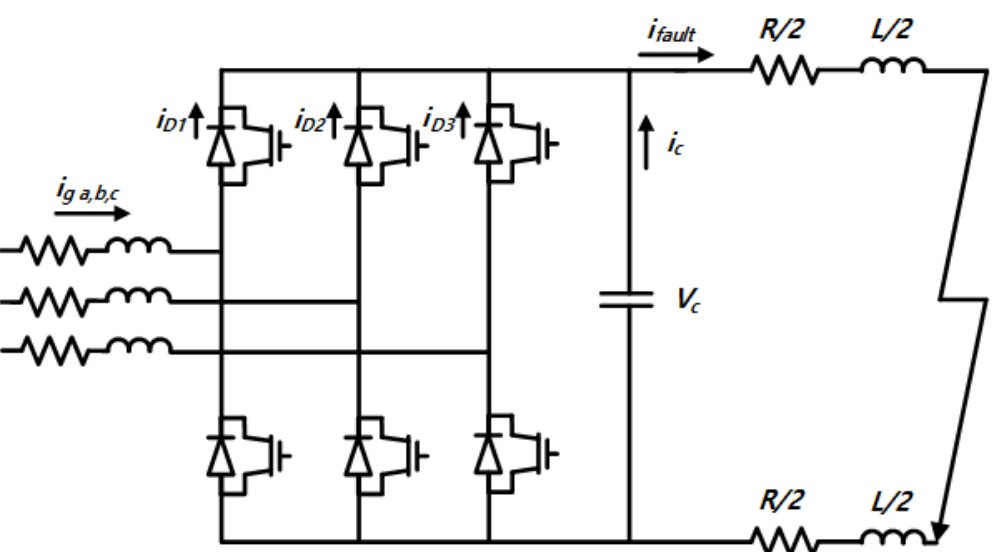
Figure 3. Equivalent Circuit for Short Circuit Fault in LVDC